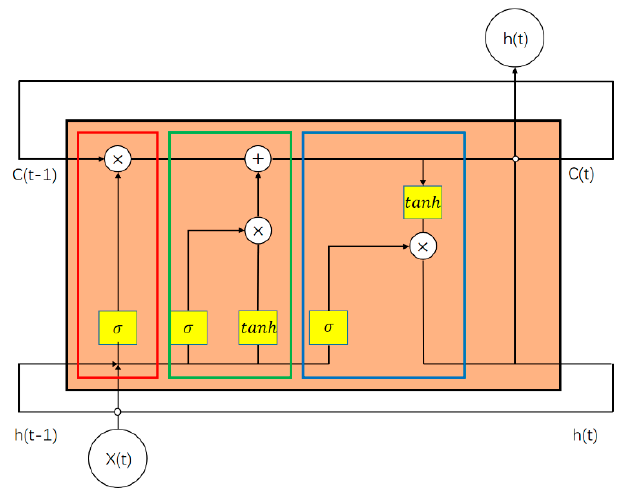
Figure 1. The structure of a LSTM cell.